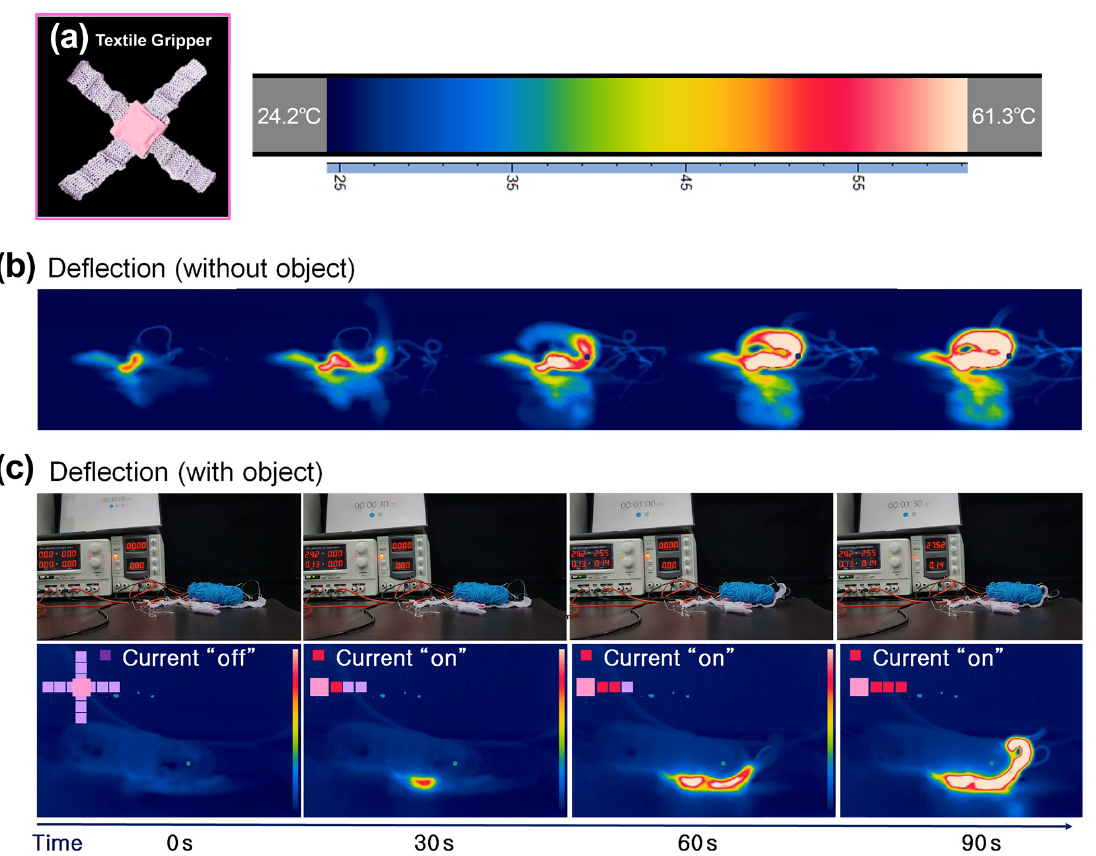
Figure 9. ( a ) Textile gripper consisting of textile actuators. ( b ) The stepwise deformation of the textile gripper without an object. ( c ) The stepwise deformation of the textile gripper with an object.